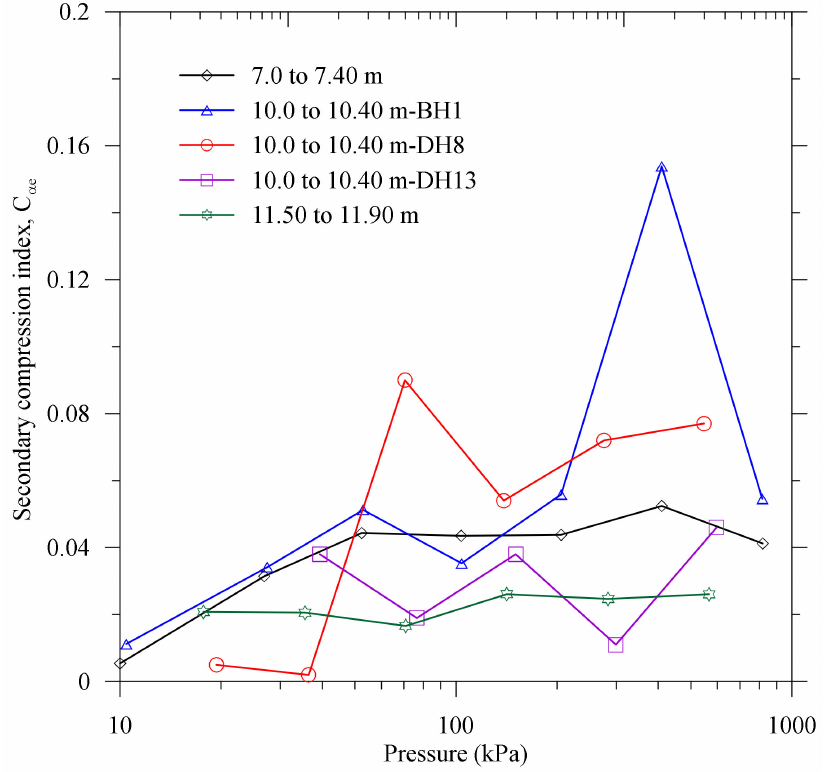
Figure 16. Relationship of the measured secondary compression index and stress